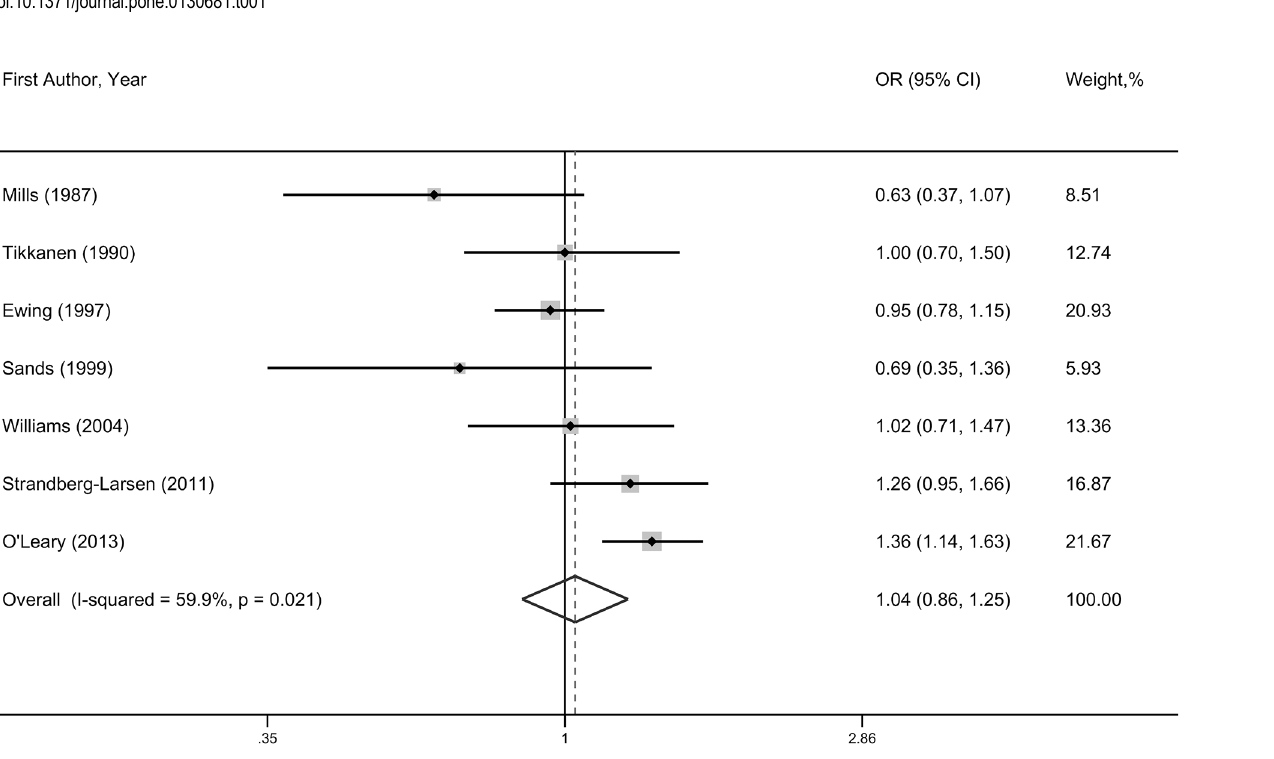
Fig 3. Forest plot of any prenatal alcohol exposure and ventricular septal defects